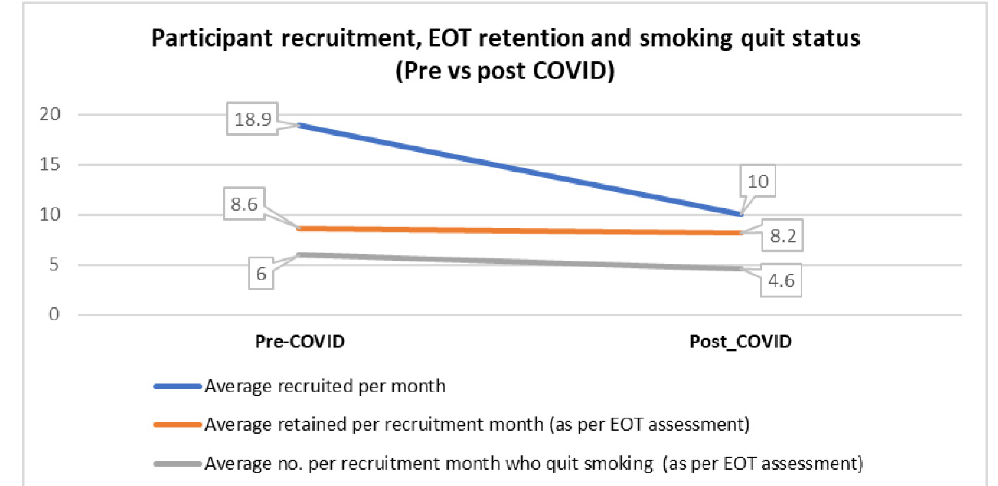
Figure 2. Pre- and post-COVID trends for recruitment, retention, and smoking quit rates.